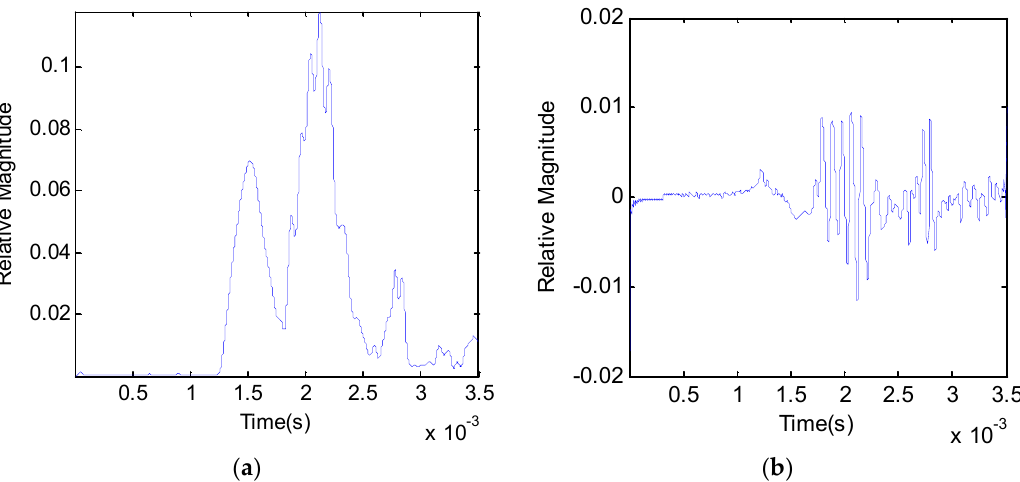
Figure 16. ( a ) Synthetic echo envelope with LFM 20–40 kHz frequency; ( b ) gradient of the synthetic echo envelope from ( a ).